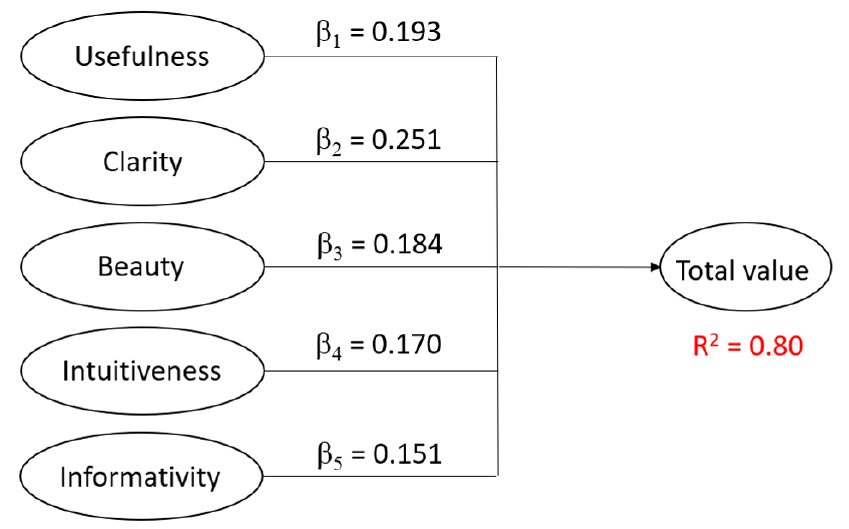
Figure 9. Regression-model coefficients for overall-value-score computation of our infographic-value (IGV) short